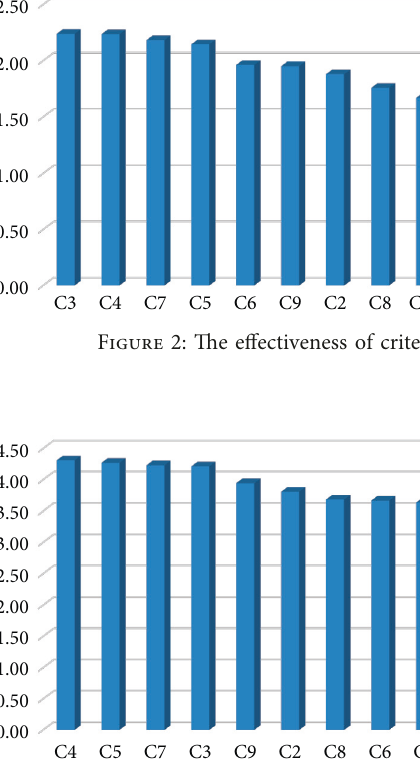
Figure 3: The sum of impact and effectiveness of criteria.